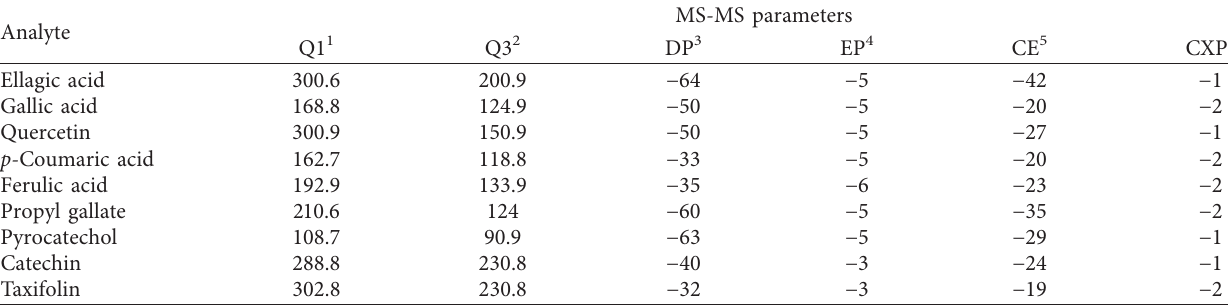
Table 1: Compound-dependent voltage parameters.